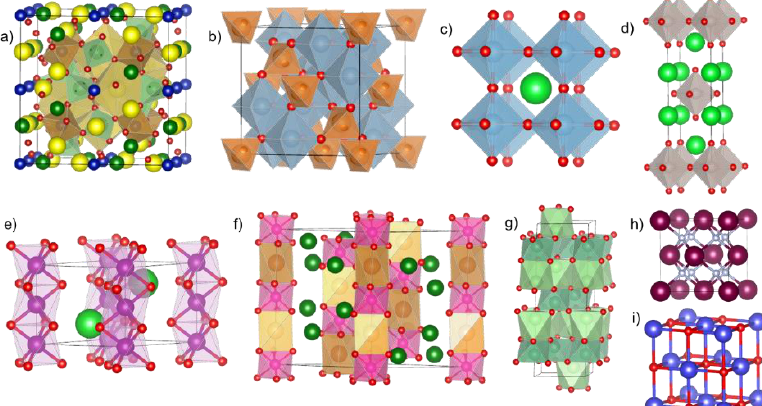
Figure 1. Crystal structure types used in this work to classify the compounds: ( a ) garnet structure, ( b ) spinel structure, ( c ) perovskite structure. An example of the layered perovskite structure is shown in ( d ), which corresponds to the Ruddlesden–Popper phase. Similarly, an example of hexagonal perovskite is shown in ( e ). The -o-tp- perovskite structure is depicted in ( f ), whereas the ilmenite structure is shown in ( g ). The fluorite and halite structures are labeled ( h , i ). The characteristic polyhedral framework in the fluorite and halite structures are not shown to facilitate their visualization.